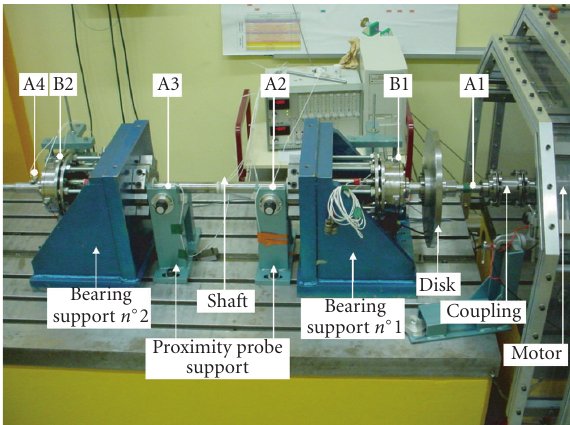
Figure 1: The test rig.